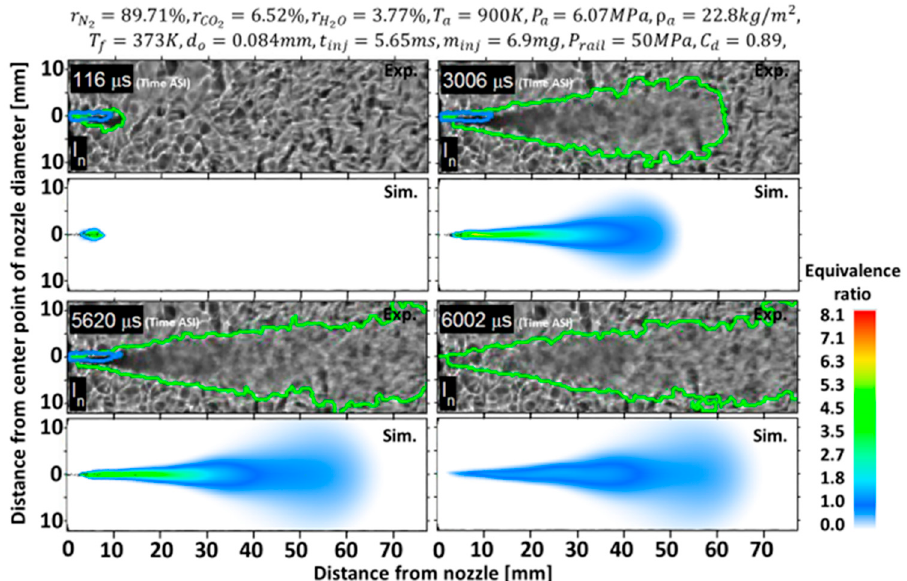
Figure 8. Comparison of the spray shapes and equivalence ratio histories of the experimental results [23] and simulation results for a rail pressure of 50 MPa.